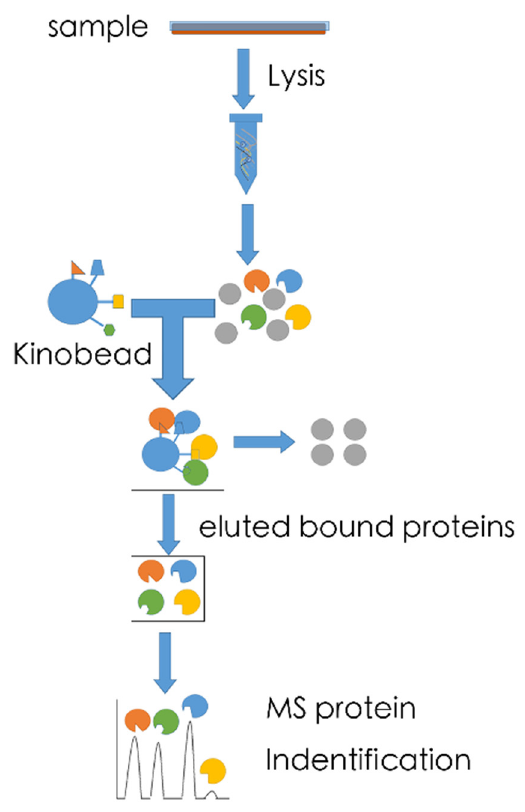
Figure 1. Kinobead-based profiling constitutes a chemical proteomics approach that entails the profiling of the interaction of small molecules with kinases. Following capture by immobilized kinase inhibitors the bound proteins are quantified in parallel by mass spectrometry using isobaric tags for relative and absolute quantification (iTRAQ) or comparable technology.